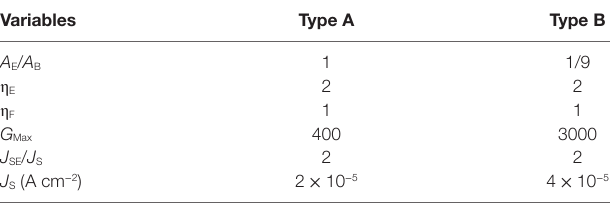
TABLe 1 | values used in plot of Figure